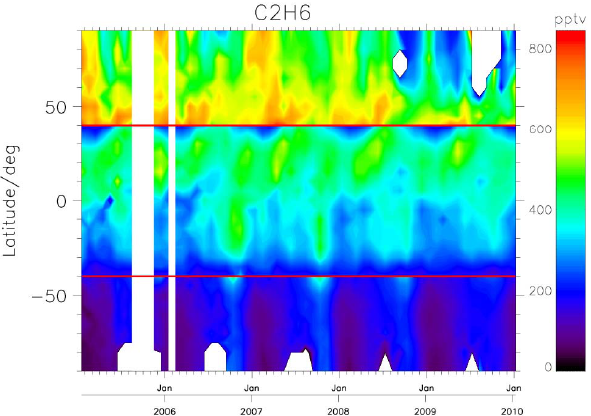
Fig. 11. Time series of C 2 H 6 vmr. Zonal monthly mean (5 ◦ width) mixing ratios are plotted versus latitude and time. For the red lines see Fig. 10.